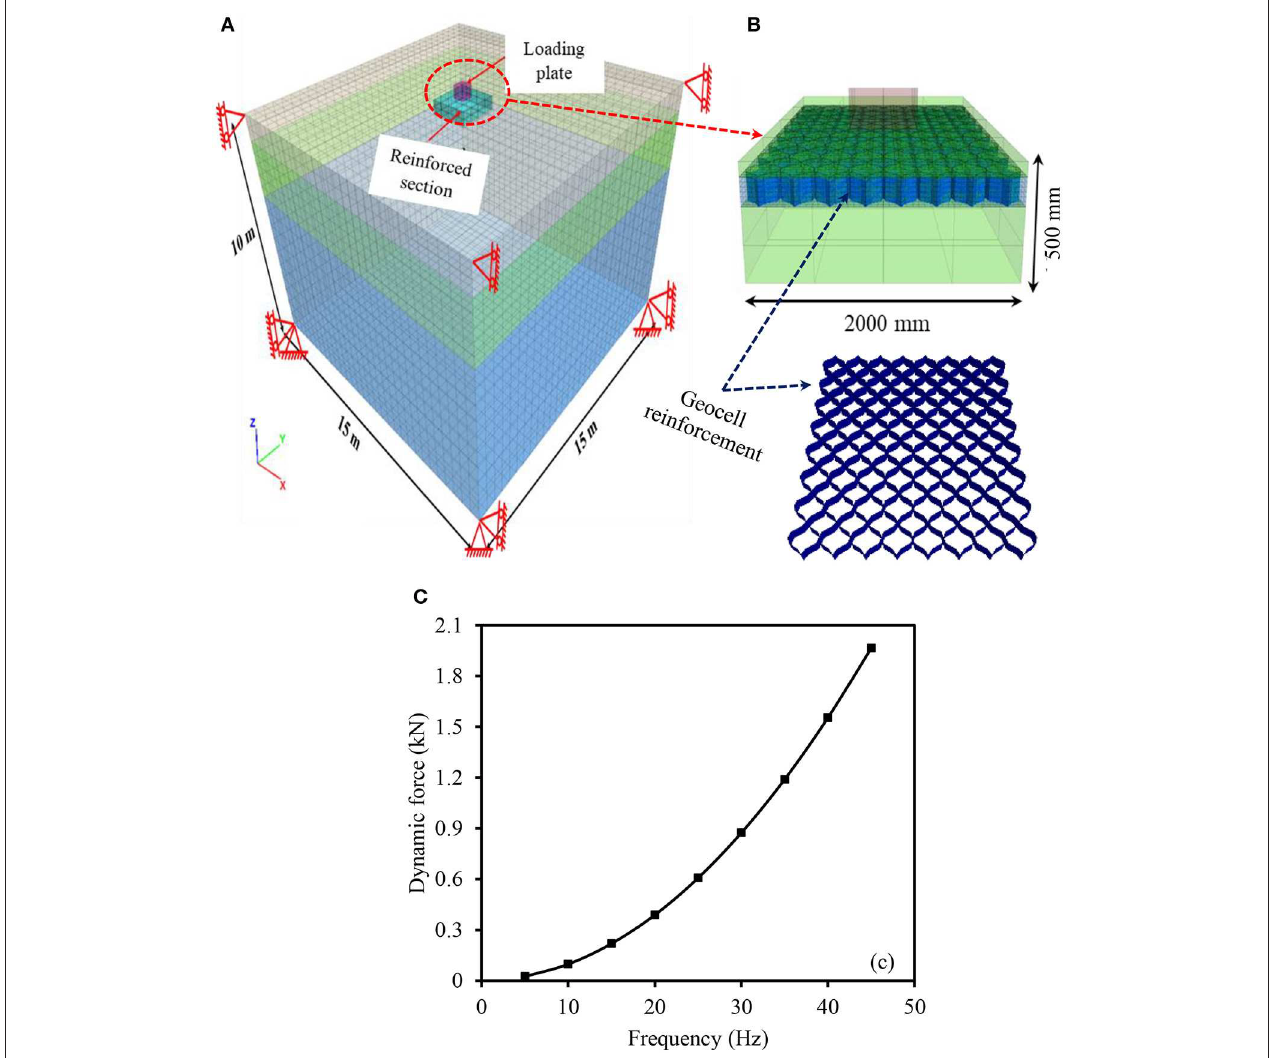
FIGURE 7 | FLAC3D numerical model: (A) unreinforced case with boundary conditions; (B) geocell reinforced subgrade (modified after Ujjawal et al., 2019); and (C) loading variation with the frequency.